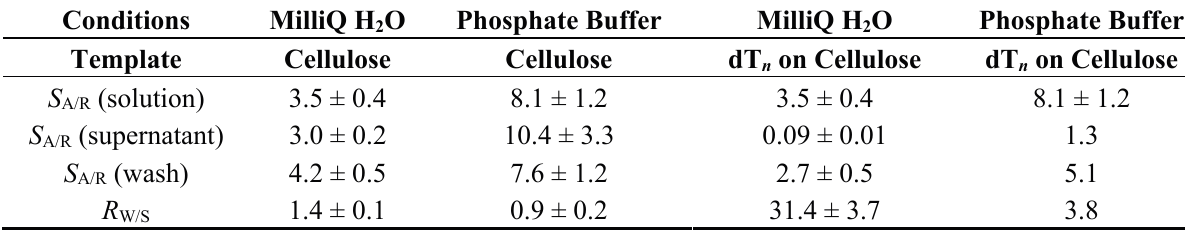
Table 1. Reductive amination reaction between Gua-Ald and benzylamine and characteristic values for the selectivity between aminated versus reduced products ( S A/R ) and for the selective retention of aminated products on the solid support ( R W/S ). Errors represent the standard deviation. “ S A/R (solution)” was determined in the absence of templates.